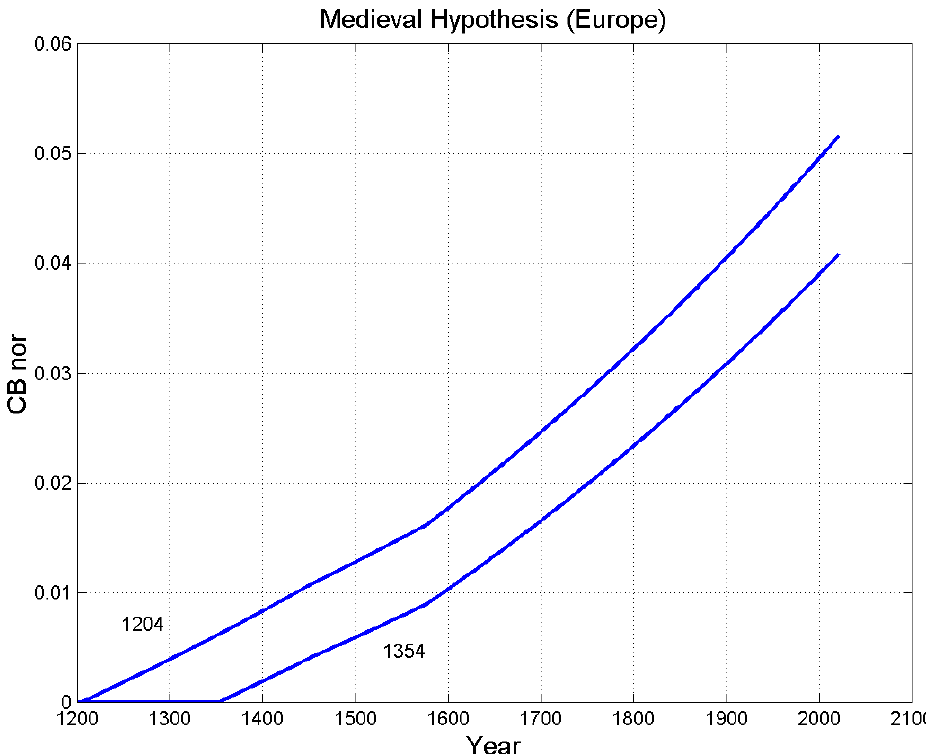
Figure 9. CB nor versus year in the Constantinople–Lirey–Chamb é ry–Turin path until the year 2021, under the hypothesis that the Shroud is a medieval linen fabric. Each curve assumes a different arrival year in Europe, t Eu , randomly generated from a uniform distribution in the interval 1204 ≤ t Eu ≤ 1354. The upper curve assumes t Eu = 1354, while for the lowest curve t Eu = 1204. In 2021, CB nor , min = 0.041 and CB nor , max =